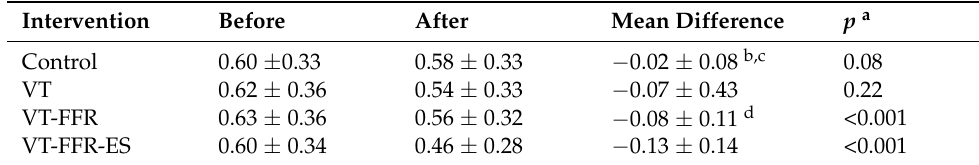
Table 2 summarizes the postinterventional changes in logMAR visual acuity. Com- pared with the values before the intervention, the postinterventional logMAR visual acuity was significantly different in the VT-FFR (0.63 ± 0.36 vs. 0.56 ± 0.32, p < 0.001) and VT-FFR- Table 3. Refractive error between chronic Control and VT-FFR-ES interventions (n = 50 eyes in each ES groups (0.60 ± 0.34 vs. 0.46 ± 0.28, p < 0.001). Thus, the VT-FFR-ES intervention was group). identified as having the best observed outcome for logMAR visual acuity (i.e., the greatest decrease in logMAR visual acuity) (Table 2). Figure 3 presents an identity plot for logMAR visual acuity in the No function group and VT-FFR-ES group after a single intervention. Table 2. The logMAR visual acuity of pre–post-evaluation of single intervention (n = 54 eyes). Intervention Before After Mean Difference p a Control